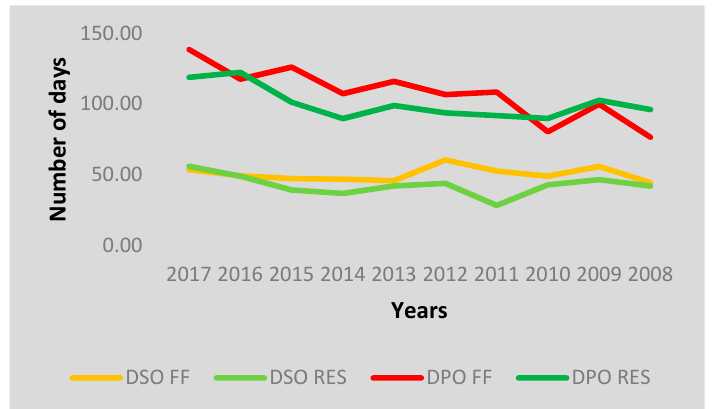
Figure 3. Yearly values of DSO and DPO for two groups of analysed companies, 2008–2017. Source: Own calculations based on data from EMIS database.